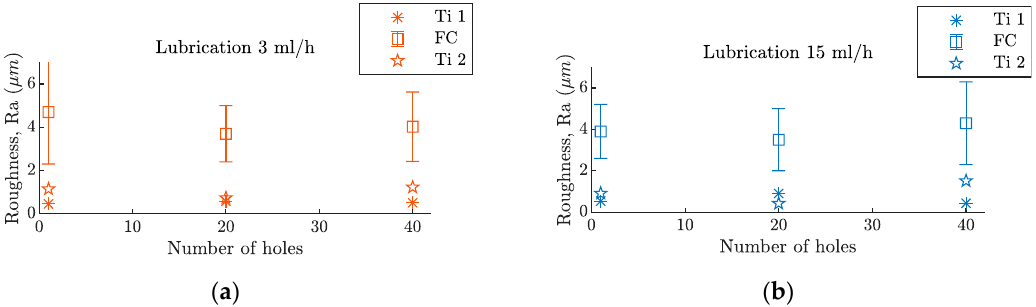
Figure 9. Roughness evolution, after 40 holes, in a hybrid Ti/CFRP/Ti stack with a ( a ) lubrication level of 3 mL/h and a ( b ) lubrication level of 15 mL/h.